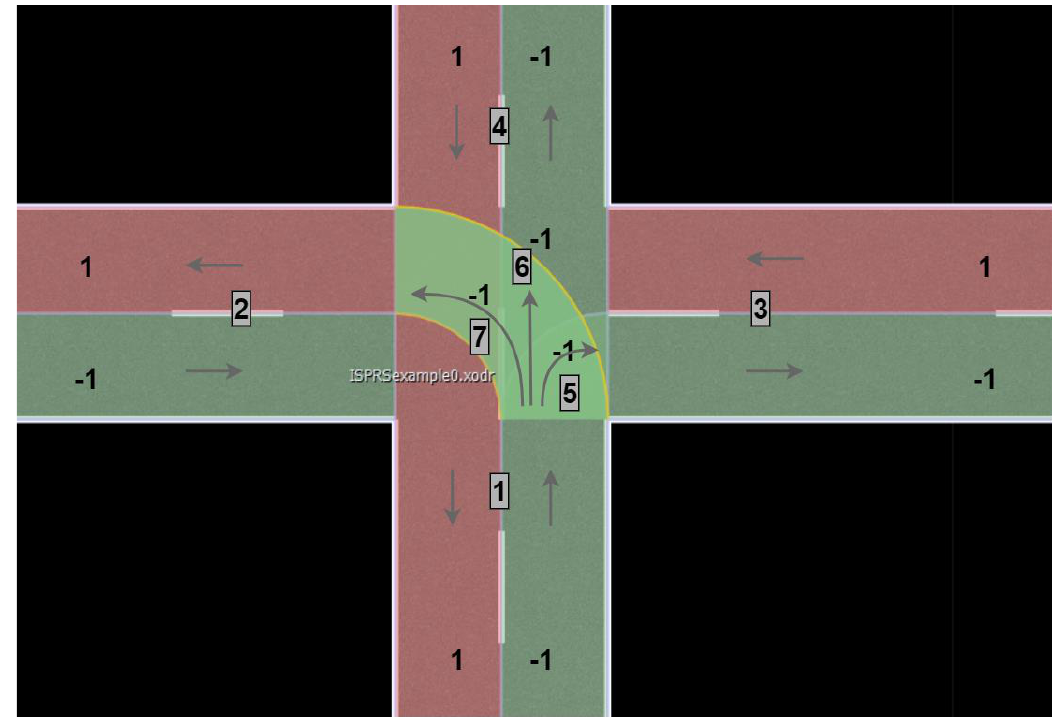
Figure 6. Road crossing of Figure 4 with lanes